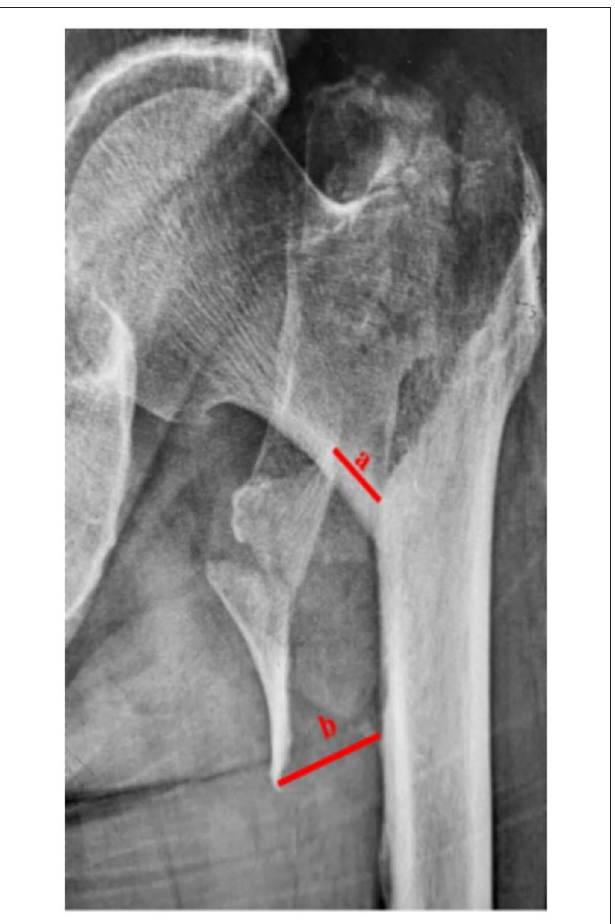
FIGURE 5 | Distance a and b are defined as the lengths from the highest fracture site to the corresponding site at the lesser trochanter and the lowest fracture site to the corresponding site at the lesser trochanter, respectively. And the displacement distance of lesser trochanter is defined as the average of the distance a and distance